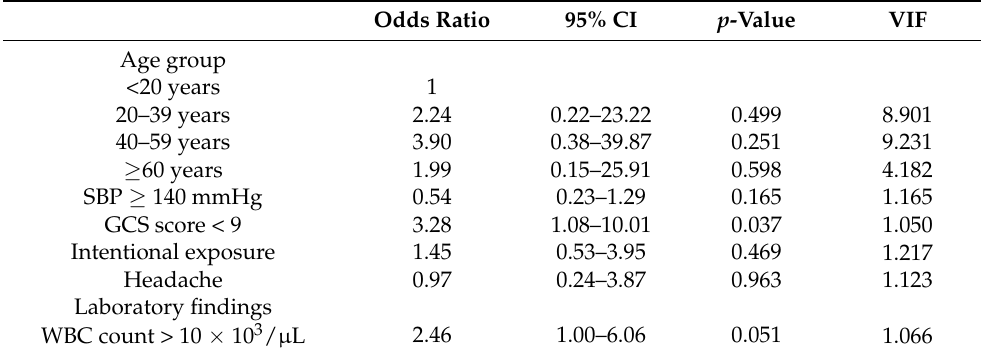
Table 3. Multiple logistic regression analysis of factors predicting acute brain